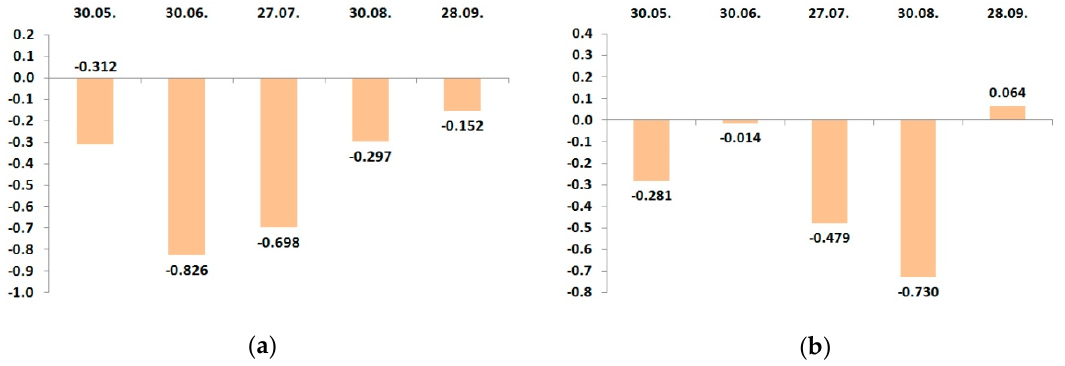
Figure 6. Dynamic changes of correlation coefficients between the leaf calcium status and potassium fertigation rates during the growing season of 2017. ( a ) cv. “Zhigulevskoye”; ( b ) cv. “Lobo”. To the end of June 2017, cv. “Zhigulevskoye” had a strong negative correlation; the relationship for cv. “Lobo” was weak and also negative. Then, in August, the situation changed conversely;